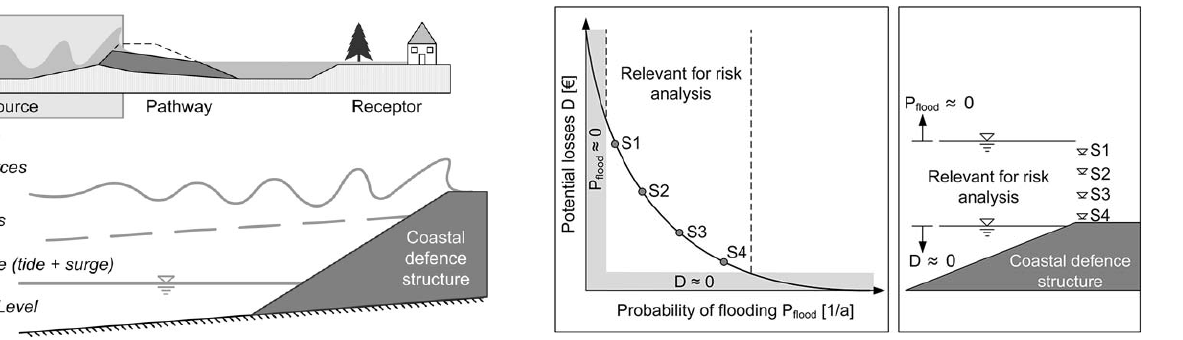
Fig. 1. Source-Pathway-Receptor Concept for risk analyses and rel- evant risk sources for coastal areas.